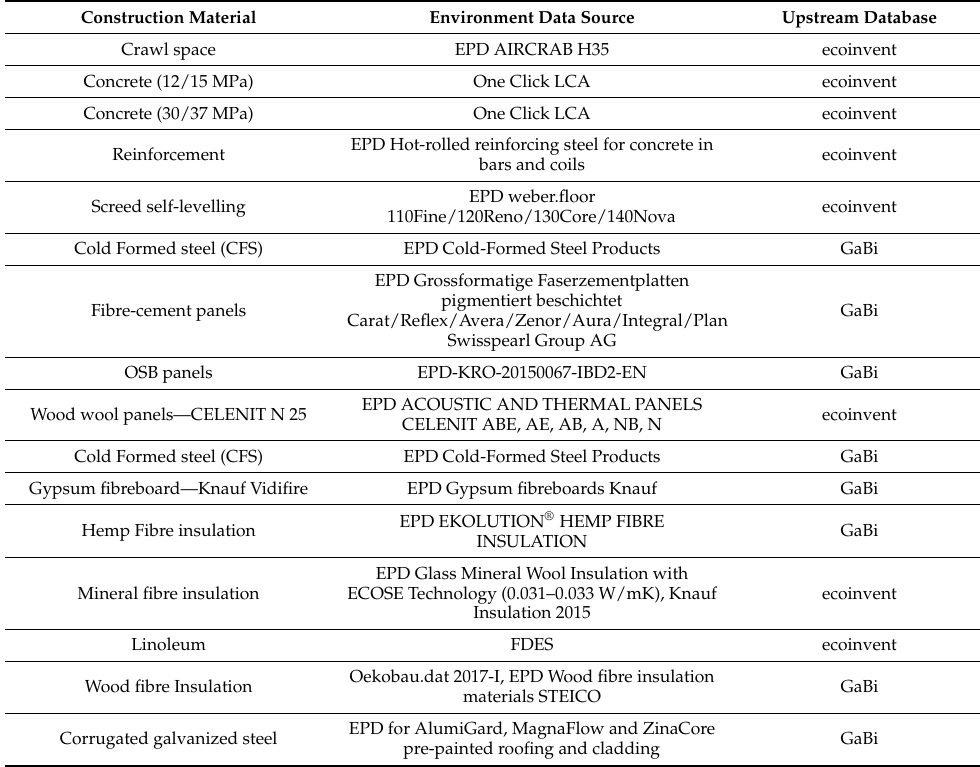
Table A1. CFS school—Life Cycle Inventory: source of